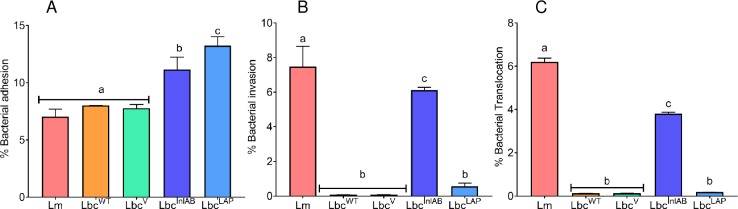
Adhesion (A), Invasion (B) and Translocation (C) of Listeria monocytogenes (Lm) and Lactobacillus casei (LbcWT, LbcV, LbcInlAB
and LbcLAP) to Caco-2 cells. Percentages were calculated relative to the inocula that were added to the Caco-2 cells. Data are average (SD) of three independent experiments performed in duplicate. Error bars are standard deviations of averages of the three independent experiments. Bars marked with different letters (a, b, c) indicate significant difference at p<0.05.